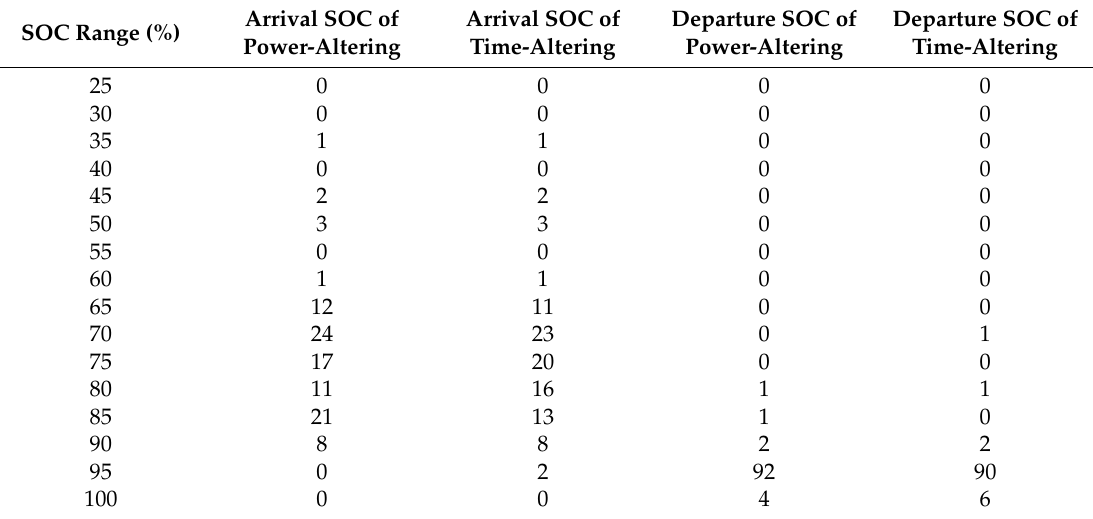
Table 2. State of charge (SOC) distribution statistics.